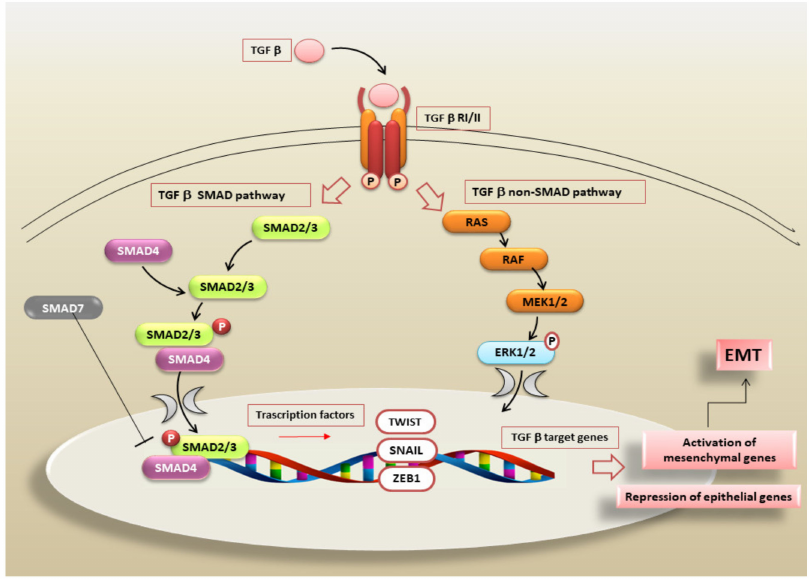
Figure 2. TGF- β , a key mediator in the pathogenesis of fibrosis. TGF- β , through the downstream factors, exerts biological activities on different cell types, acting as a central molecule in the activation of the fibrotic